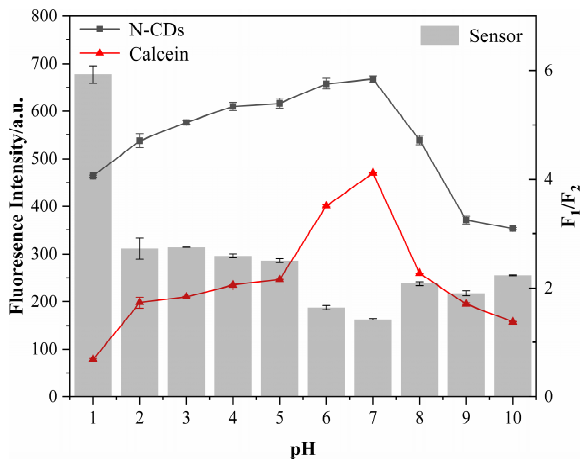
Figure 7. Effect of pH on the fluorescence intensity of N-CDs, calcein and N-CD/calcein sensor. To examine the ionic strength effect of the fluorescence intensity, we explored its effects on N-CDs, calcein and the N-CD/calcein sensor (Figure 8). As shown in Figure 8, when the ionic strength was increased up to 1.0 mM, the fluorescence intensity of the N-CDs did not show a visible change, while the fluorescence intensity of calcein experienced a slight decrease at 0.8 and 1.0 mM. According to the calculation of the F 1 /F 2 ratio, our N-CD/calcein sensor did not fluctuate; even the ionic strength was stable at 1.0 mM, indicating its tolerance to salinity.